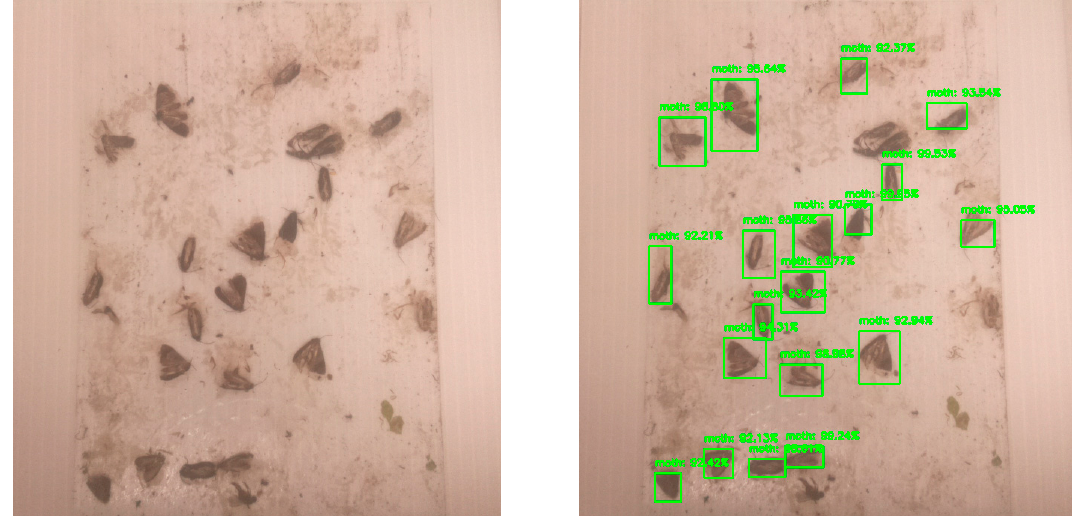
Figure 10. Sample image of cached insects taken by the sensing device ( left ) and the moths detected by the insect-counting algorithm ( right ).